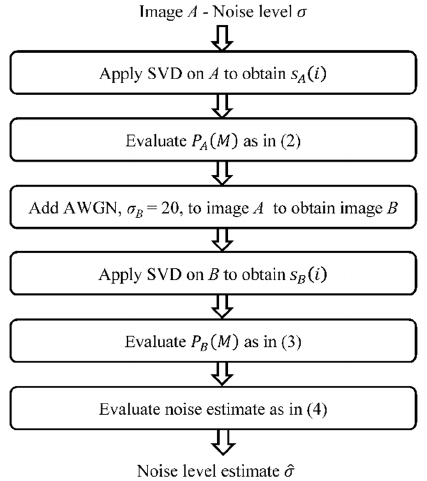
Figure 2. Noise level estimation in the singular value decomposition (SVD) domain.